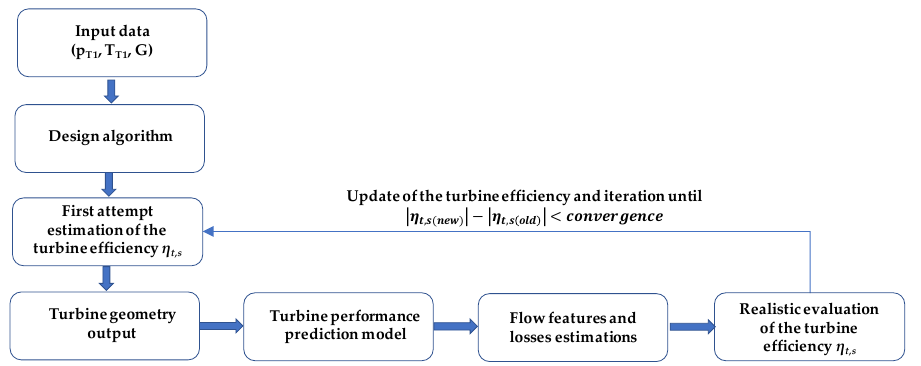
23 of 27 Figure 8. Inlet volute area geometry. 3.4. Design Calculation Procedure With the aim to explain the whole calculation procedure adopted for the radial tur- bine design, Figure 9 shows a flowchart summarizing the main steps followed by the au- thors for the definition of the turbine geometry, which are listed below: The input data (total pressure and temperature at turbine inlet, mass flow) are fed to the algorithm design block. The algorithm design block estimates a first attempt value for the total-to-static effi- ciency of the turbine. The total-to-static efficiency of the turbine is employed by the algorithm design block to define the turbine geometry. The turbine geometry is fed to the performance prediction model for the realistic evaluation of all the energy losses, giving as a final result the realistic total-to-static effi- ciency.